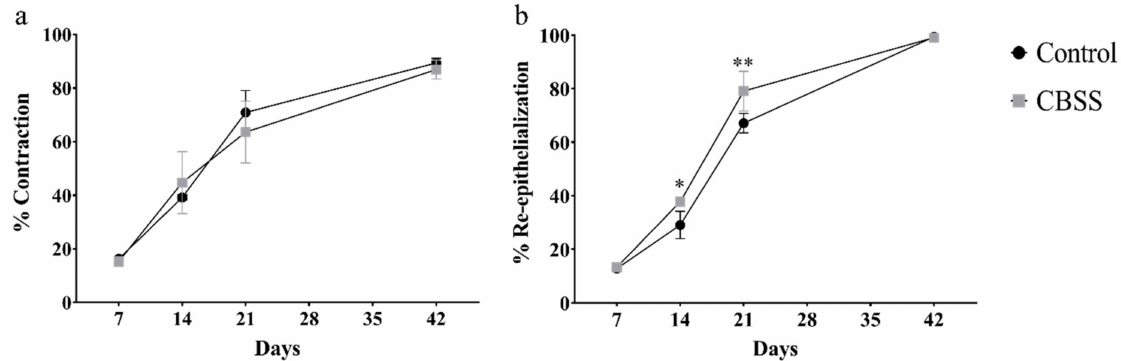
Figure 4. ( a ) Percentage of contraction. ( b ) Percentage of re-epithelialization. Data are shown as mean ± SEM. * p < 0.05; ** p <